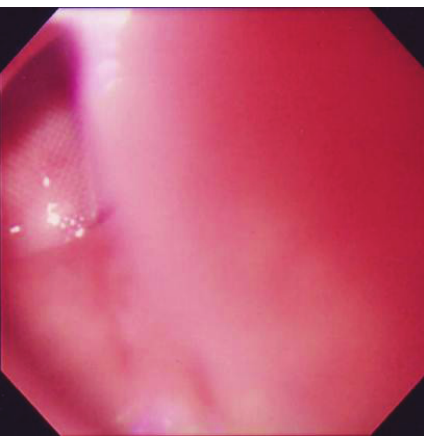
Figure 3: On postadmission day 18, chest X-ray revealed a covered self-expanding esophageal stent (black